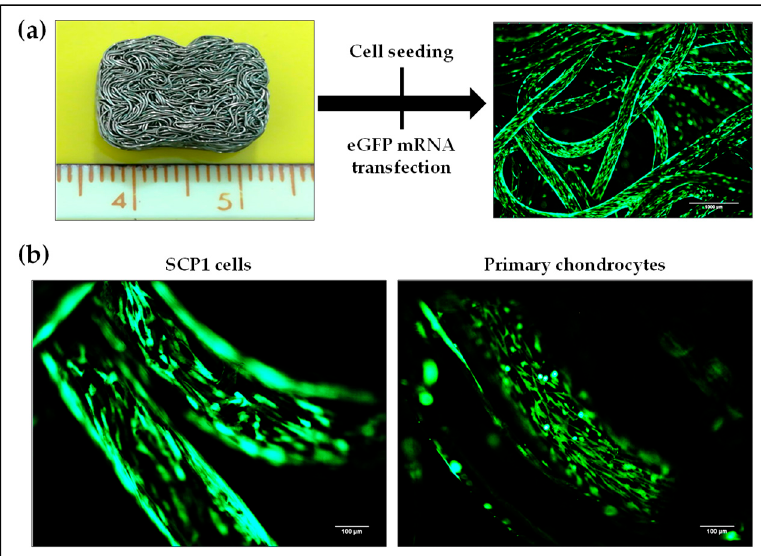
Figure 7. eGFP mRNA transfection of cells seeded on knitted titanium scaffolds. ( a ) Illustration of cell seeding on the knitted titanium scaffolds, and the following eGFP mRNA transfection. ( b ) Positive eGFP expression of SCP1 cells and human primary chondrocytes adhered to knitted titanium scaffold confirmed successful mRNA transfection. Scale bar = 100 µm.